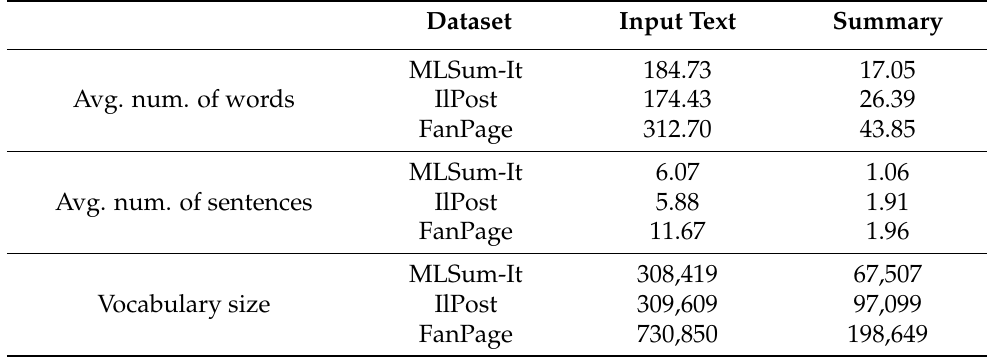
Table 1. Average number of words and average length in terms of number of phrases and vocabulary size for the MLSum-It, IlPost, and Fanpage datasets.